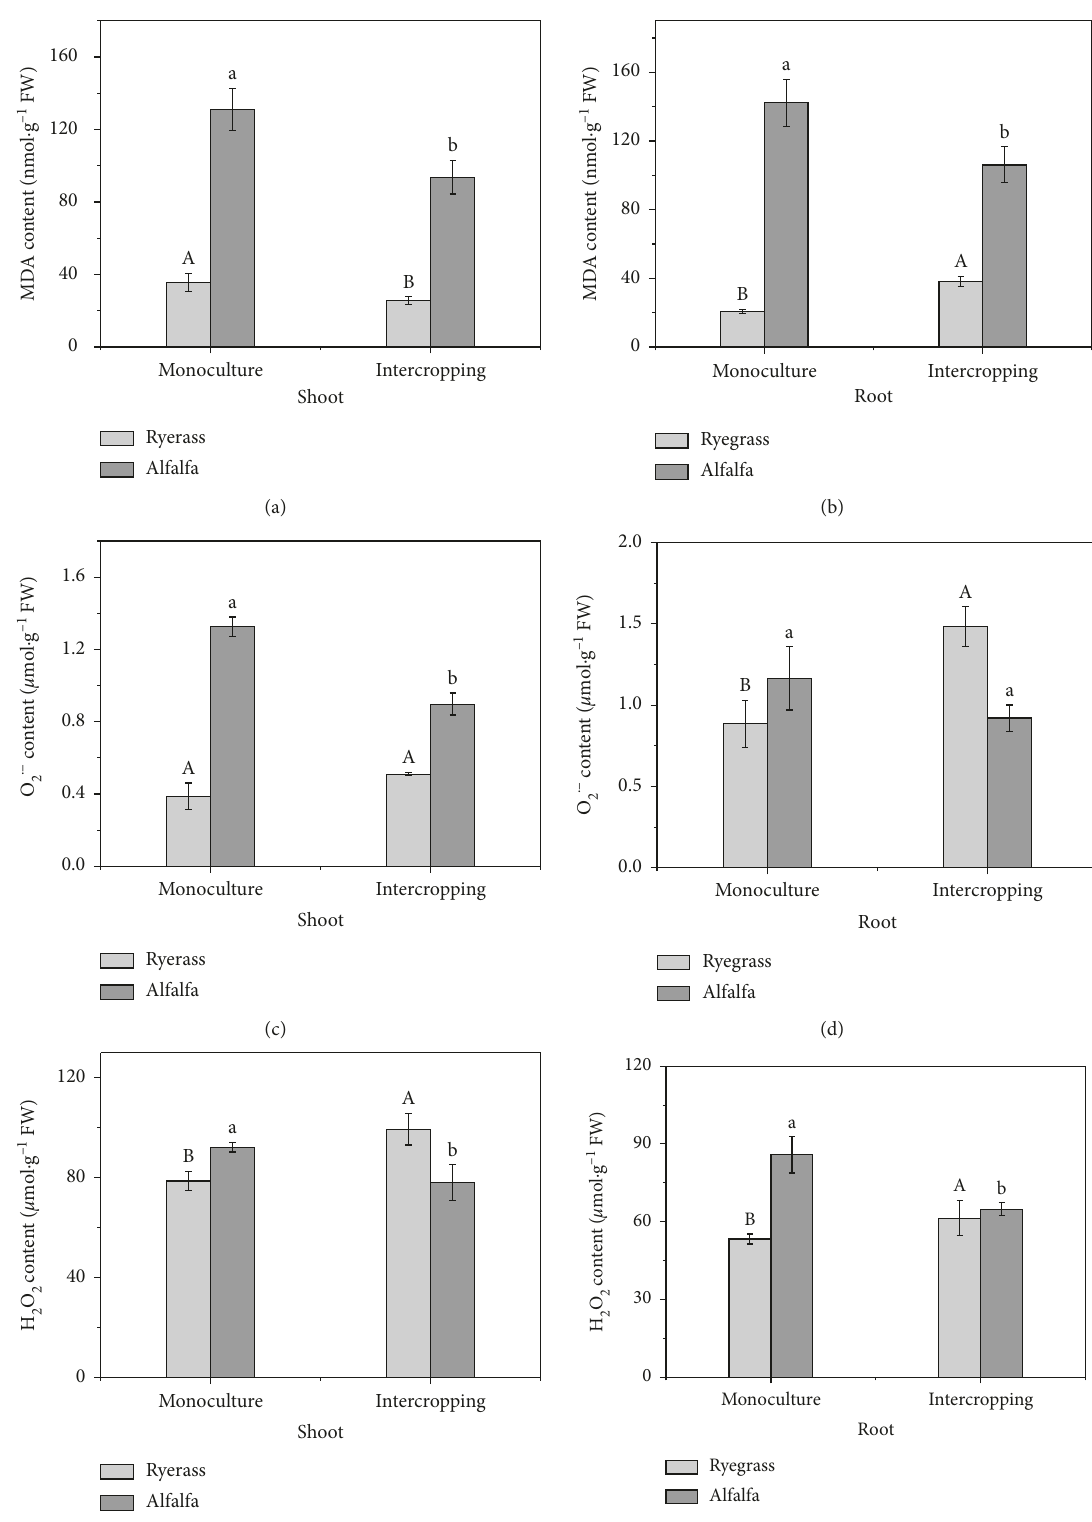
Figure 4: The MDA, O · − and H 2 2 O 2 content in shoots and roots of ryegrass and alfalfa under the monoculture and intercropping treatments. MDA content in shoots (a), MDA content in roots (b), O 2 · − content in shoots (c), O 2 · − content in roots (d), H 2 O 2 content in shoots (e), and H 2 O 2 content in roots (f). Bars are the standard error ( n � 3). Means followed by the same letter are not significantly different at p < 0 . 05 of ryegrass and alfalfa with different